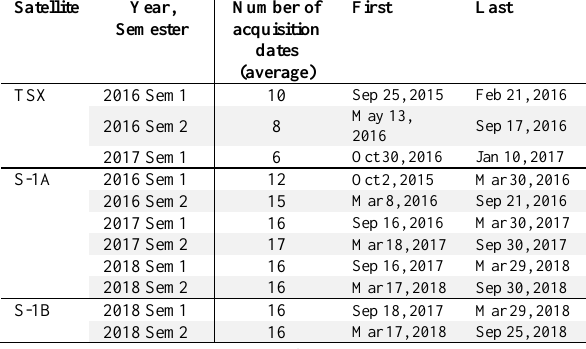
Table 2. SAR images used for each year and